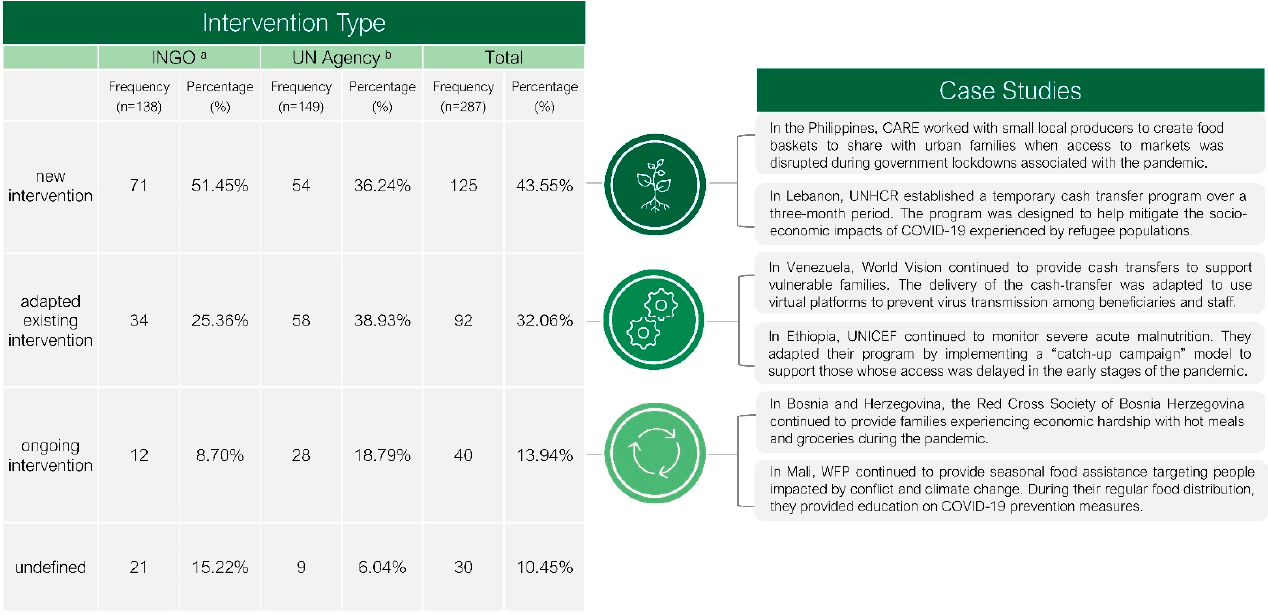
Figure 3. Intervention type and case studies of food security interventions delivered by INGOs and UN agencies in response to the COVID-19 pandemic in low- and middle-income countries from 31 December 2019 to 31 May 2020 ( n = 287). a INGO = international non ‐ governmental organization. b UN Agency = United Nations Agency.